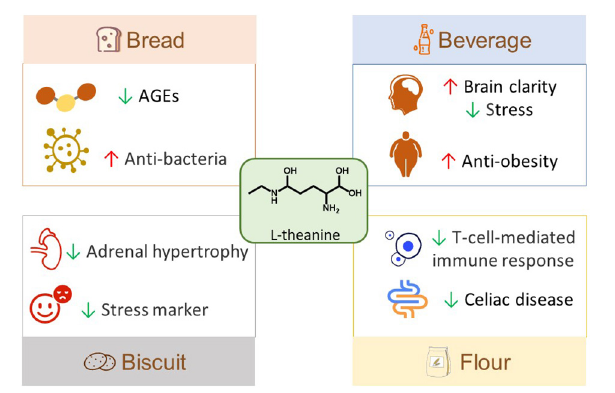
FIGURE 3 | Food applications of L-theanine. AGEs, advanced glycation end